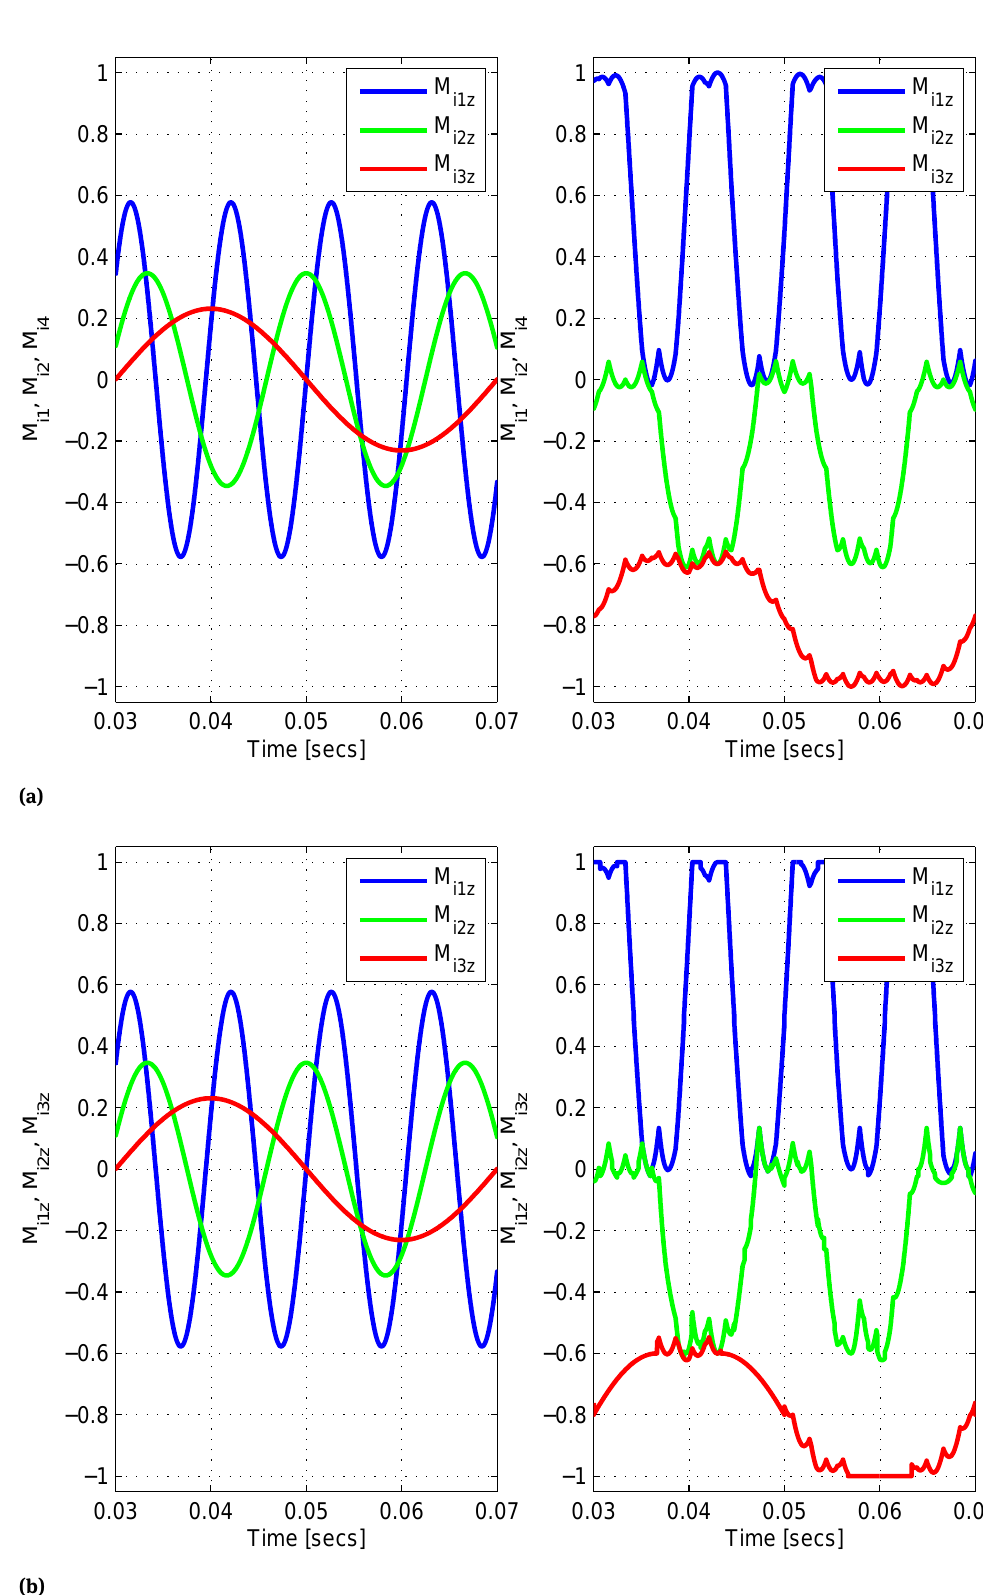
Figure 5: 12 -switch simulated phase a modulation signals: reference (left) and derived (right) for (a) continuous and (b) discontinuous